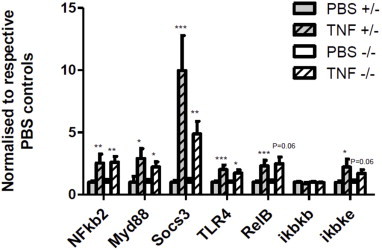
To test the ability of TNFα upregulation of NFκB pathway gene expression, hypothalami of Fto+/− (n = 14 with PBS; n = 12 with TNFα) and Fto−/− (n = 7 with PBS; n = 13 with TNFα) were obtained four hours after central injection of PBS saline or TNFα. Data are presented as mean ± SEM and are plotted as a ratio of the value obtained with respective saline treatment. *, p < 0.05; **, p < 0.01; ***, p < 0.001 following two-tailed t-test.